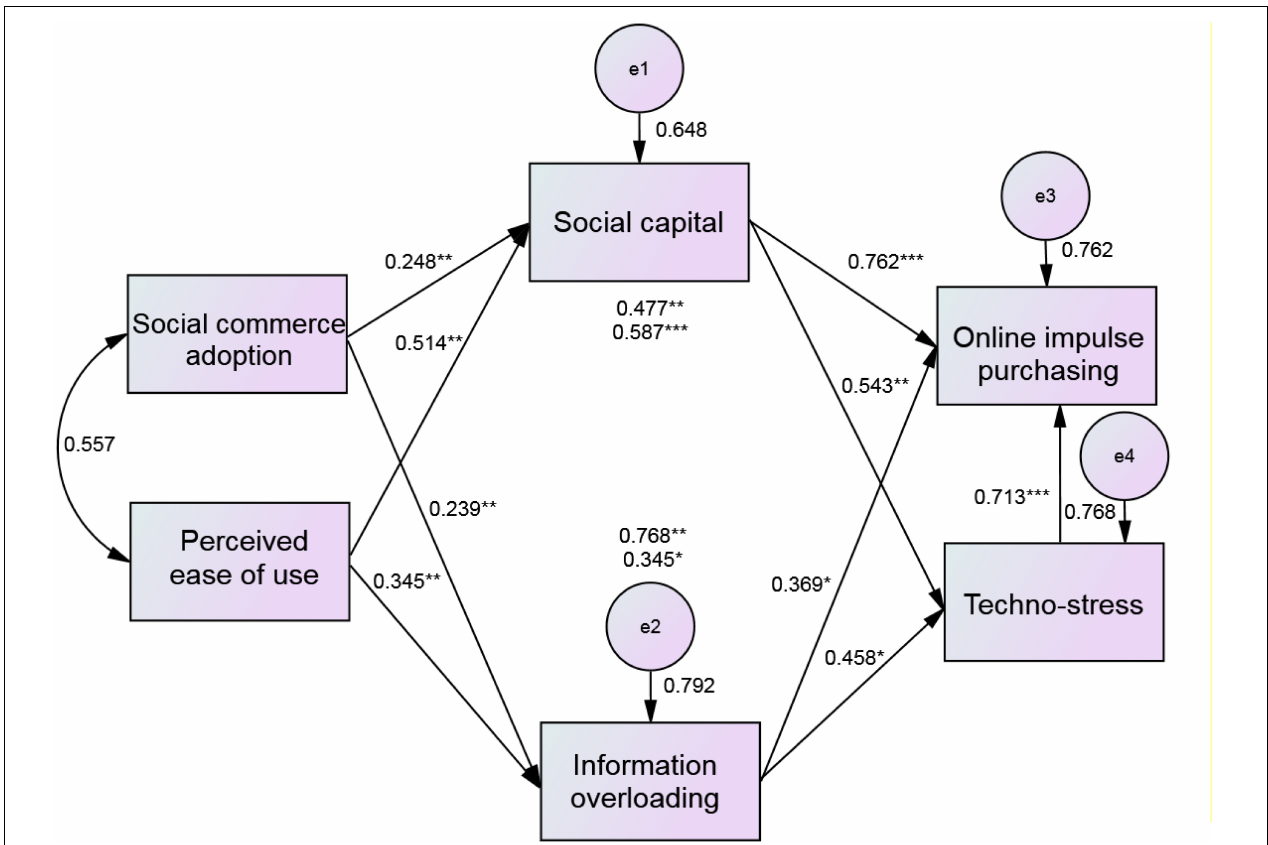
FIGURE 1 | Schematic representation of